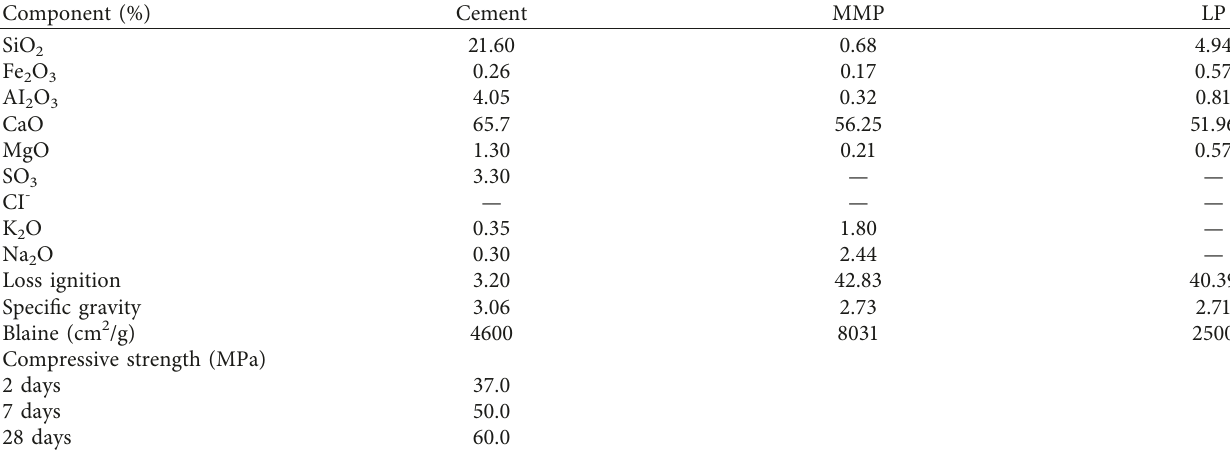
Table 1: Mechanical, physical, and chemical properties of cement and mineral admixtures.